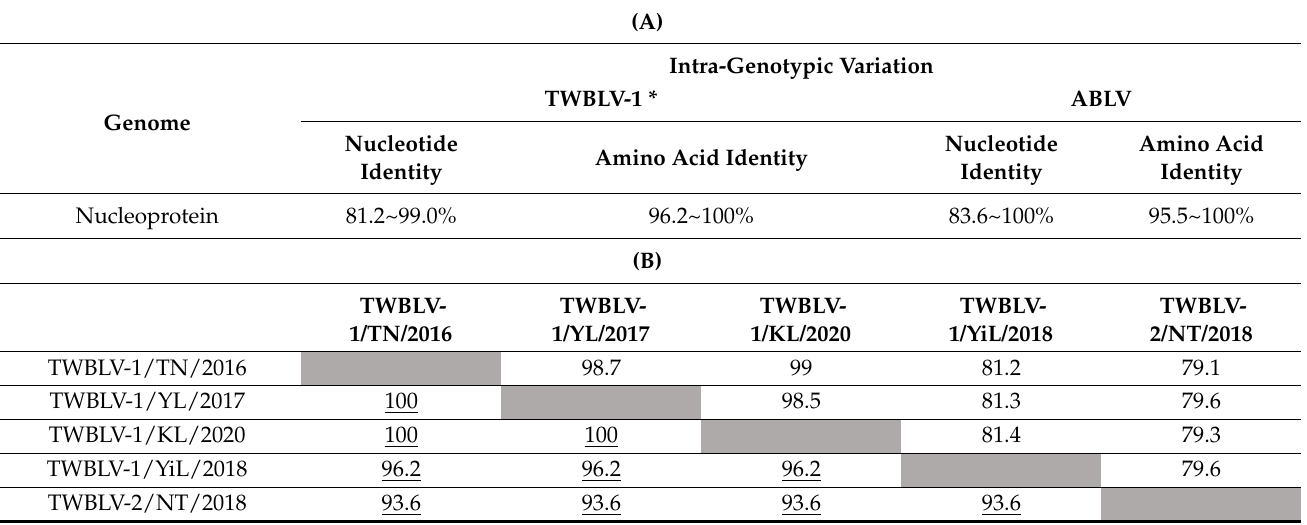
Table 3. (A) The intra-genotypic nucleotide and amino acid identities of the nucleoprotein gene